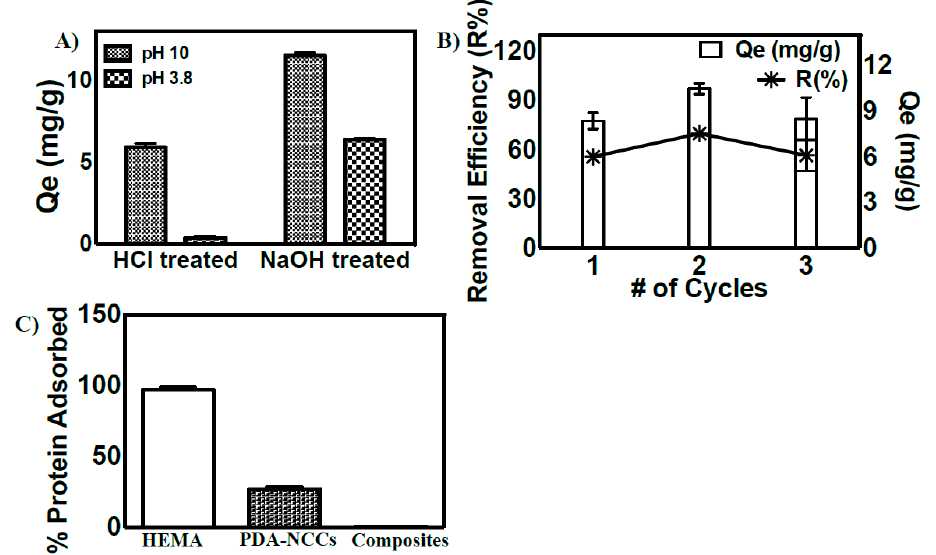
Figure 5. ( A ) The evaluation of the reusability of the composite at acidic and basic pH; ( B ) Iron absorption (shown by Qe) and desorption (shown by R%) on the surface of the polymeric composite after multiple cycles of NaOH treatment; ( C ) Evaluation of % protein adsorption efficacies on the surface of hydrogels (HEMA gels), polydopamine-coated NCC, and on the polymeric composite.